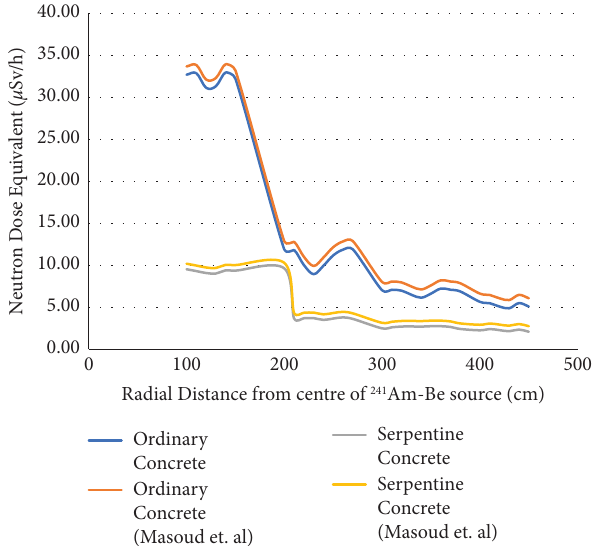
Figure 7: Comparison of results of neutron dose equivalent versus radial distance from the centre of 241 Am-Be source with